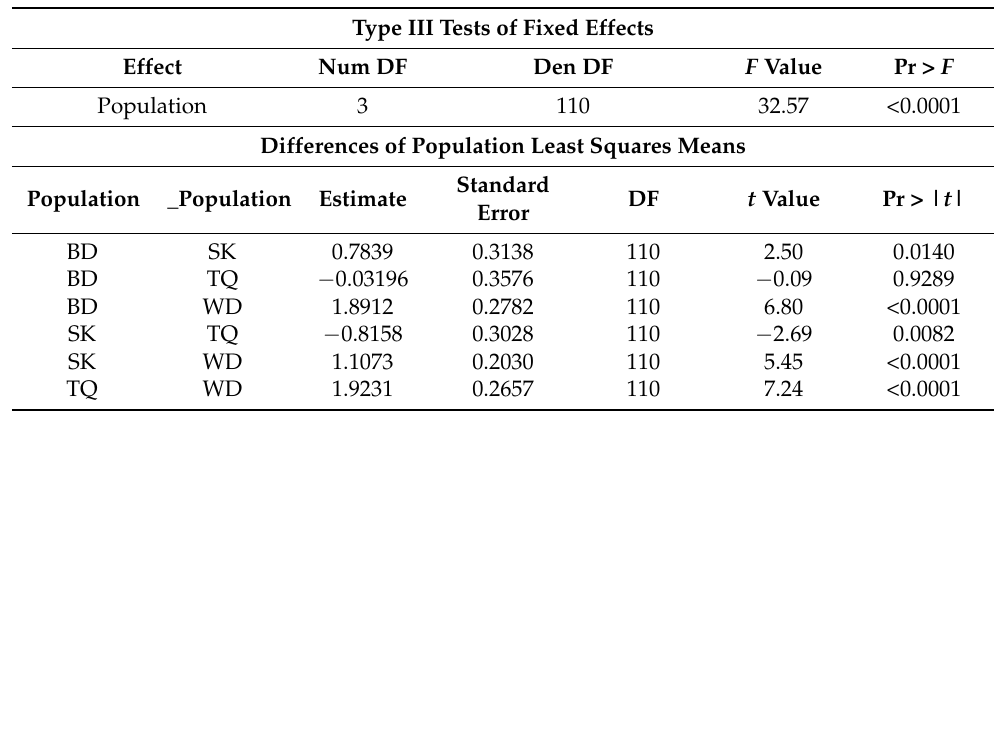
Table A10. 2020 Four Population Fruit